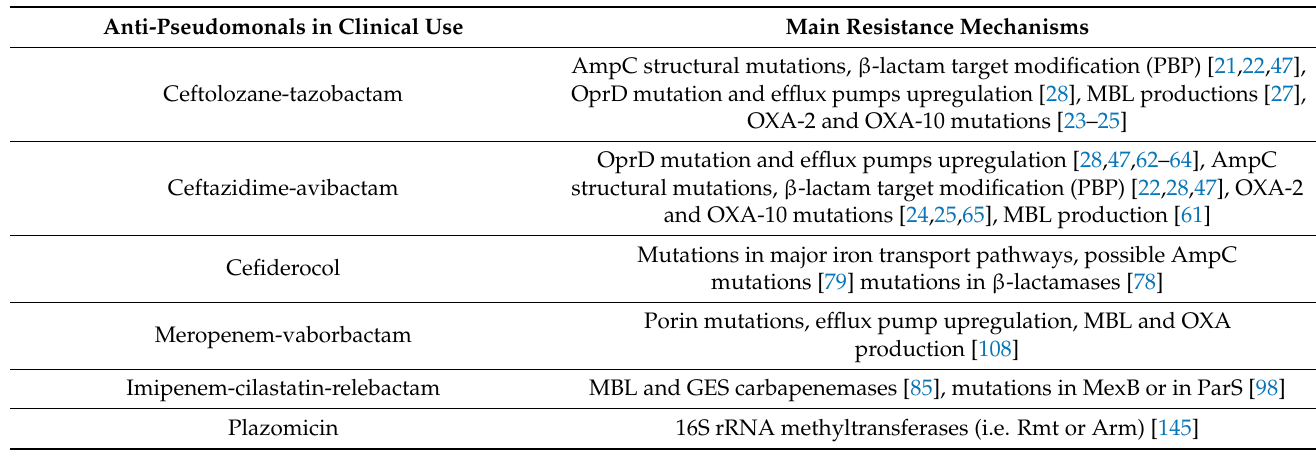
Table 1. Main resistance mechanisms of new